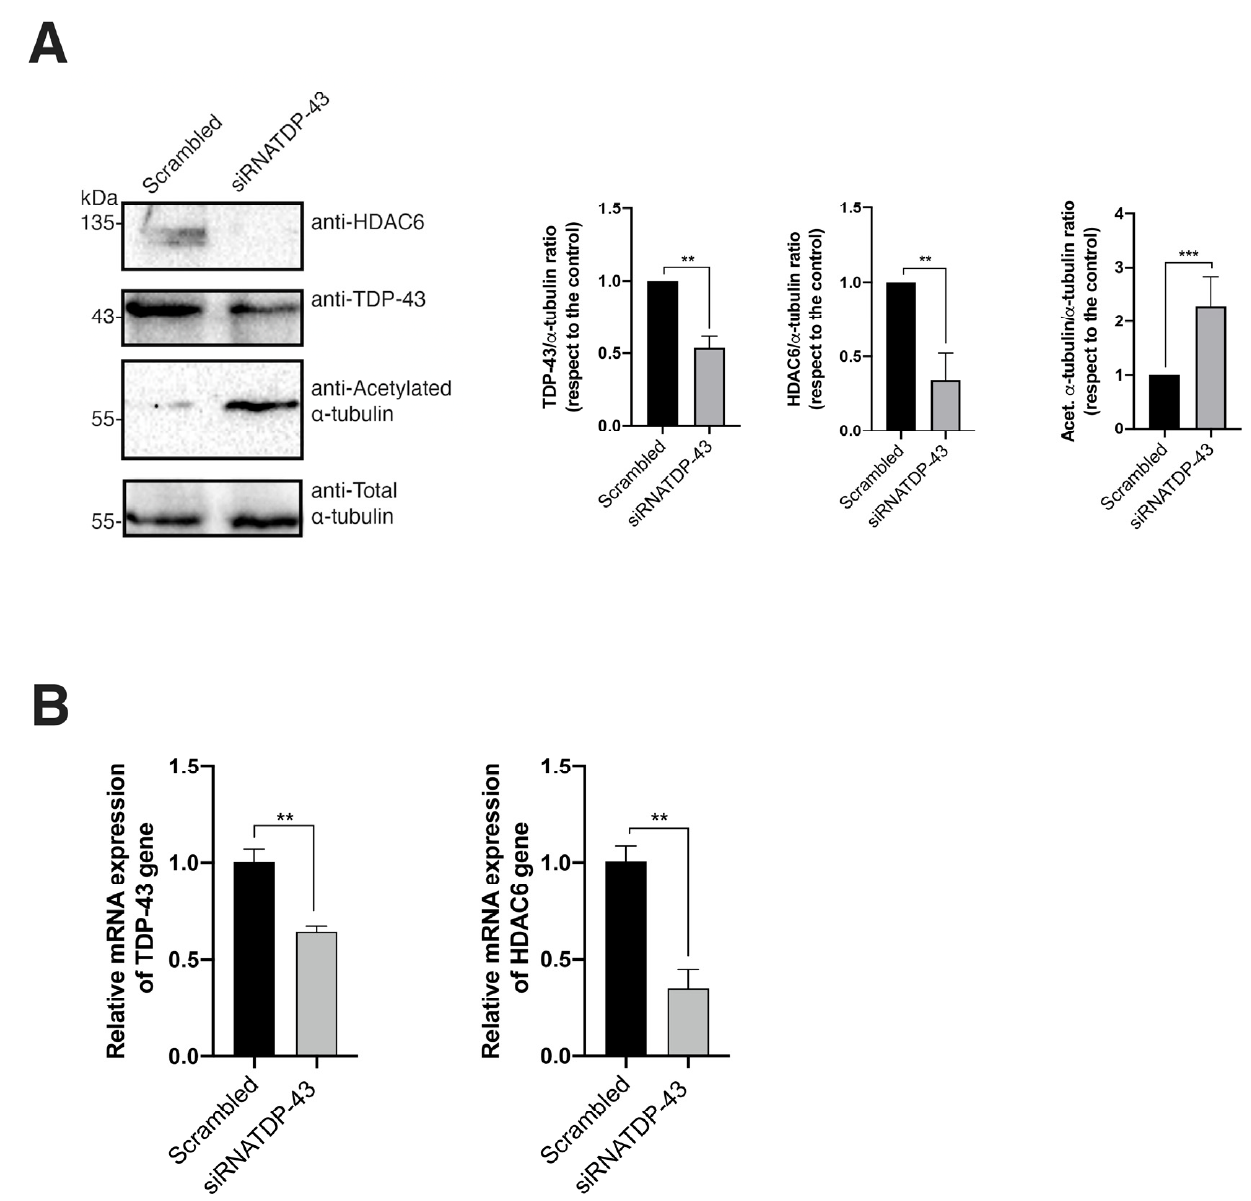
Figure 6. Specific TDP-43 mRNA silencing diminishes mRNA and protein levels of HDAC6. ( A ) The biochemical western blot analysis of endogenous TDP-43 and HDAC6 protein expression levels in HEK-293T cells transfected with a mix of siRNA oligonucleotides (siRNA-TDP-43 (B + C)) against TDP-43 (siRNATDP-43 experimental condition) or the control, which was scrambled-treated cells. The HDAC6 subtract acetylated α -tubulin in MTs is shown. Total α -tubulin for protein load control is shown under each experimental condition. Data are represented as the mean ± S.E.M. of three independent experiments (see replicate data in Figure S6, Supplementary Materials section). His- tograms show the quantification of western blot bands for the TDP-43/, HDAC6/, and acetylated α -tubulin/ α -tubulin ratio under this experimental condition. Data associated with the quantification of replicates are shown in Figure S6, Supplementary Materials section). ( B ) The relative quantification of TDP-43 and HDAC6 mRNA by RT-qPCR (3 replicates) is represented in histograms in siRNA- TDP-43-treated HEK-293T cells or the control, which was scrambled-treated cells. In ( A , B ), when indicated, ** p < 0.001 and *** p < 0.001 are the p values for Student’s t